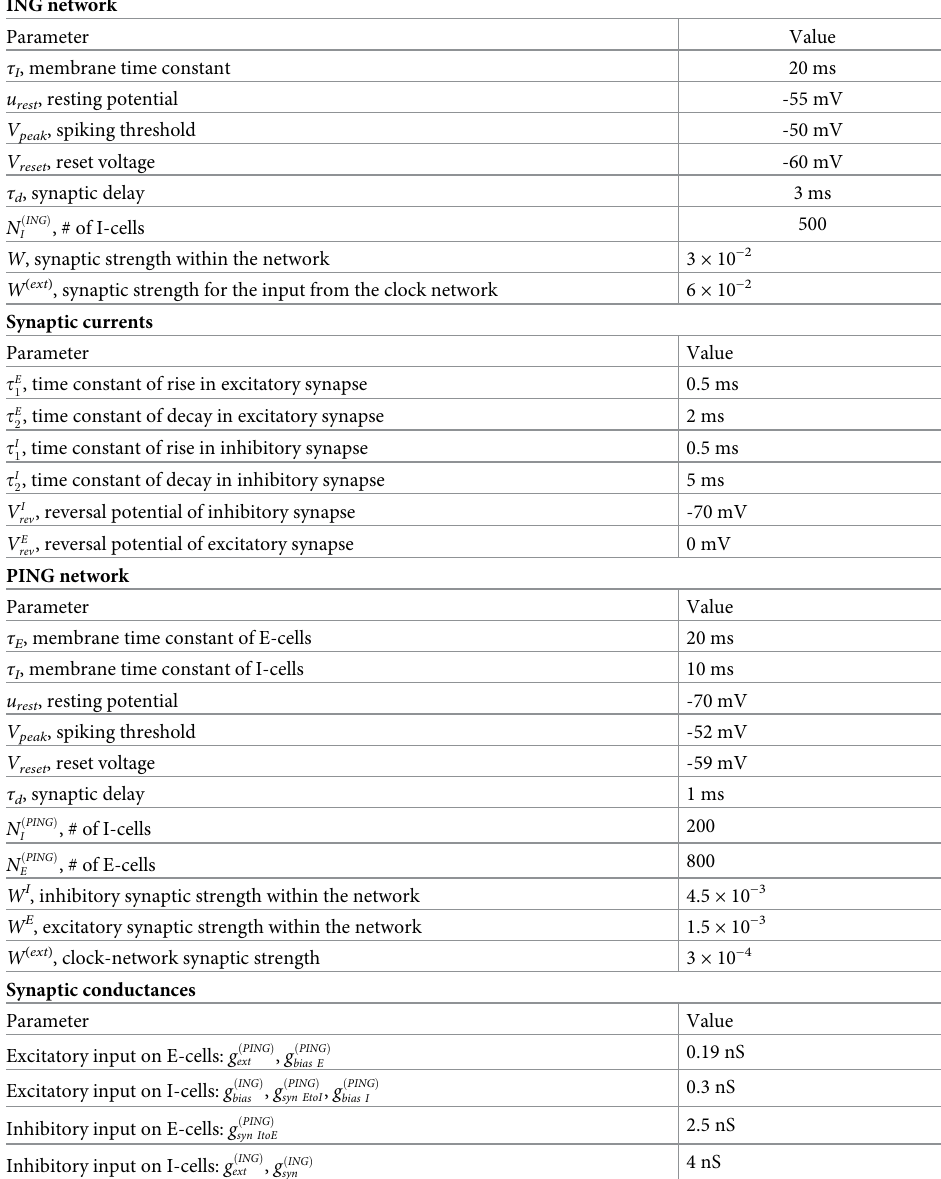
Table 1. Parameters used in the network model of IF neurons. Most parameters are based on [29, 46]. ING